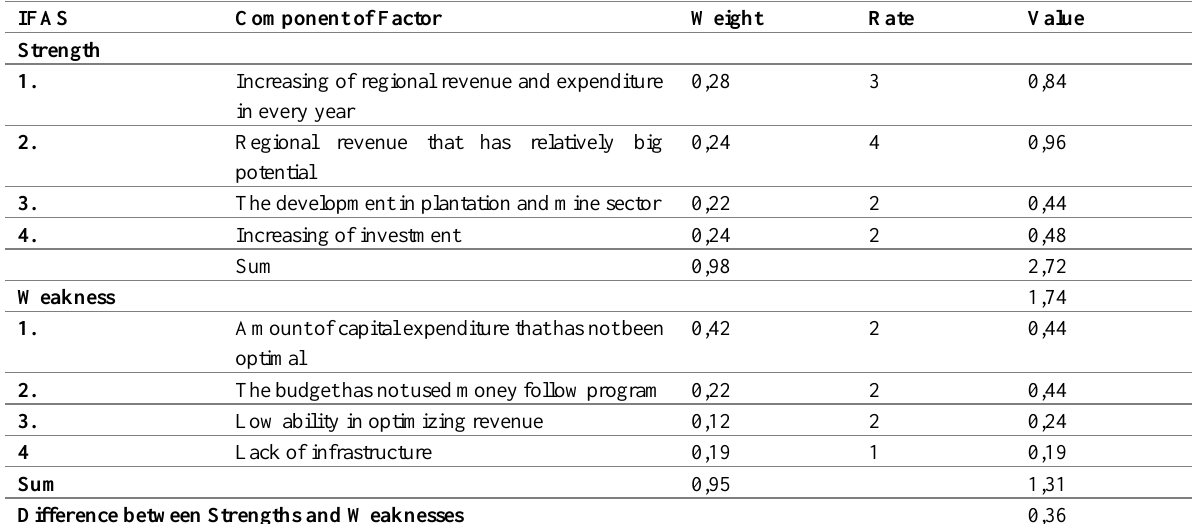
Table 2: Analysis result of Internal Factor